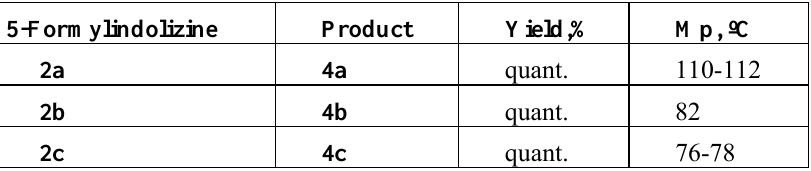
OH indolizines 4 2